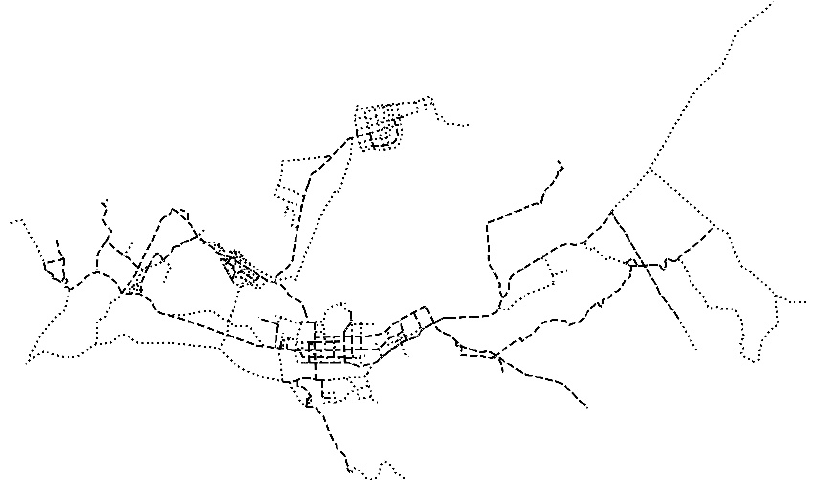
Figure 9. Schematic diagram of coverage of part of the Qitaihe bus network.